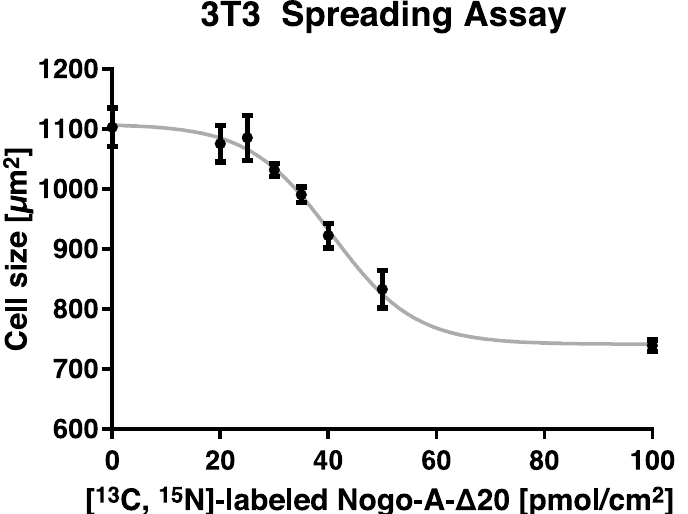
Fig 7. Activity assay of 13 C, 15 N-labelledNogo-A- Δ 20. 3T3 fibroblastswere plated on Nogo-A- Δ 20 or controlsubstratefor 1 h and fixed with paraformaldehyde. Non-linear regressionreveals an IC 50 value of ~40 pmol/cm 2 . Mean cell size ± standarddeviation fromthreewells is shown for each